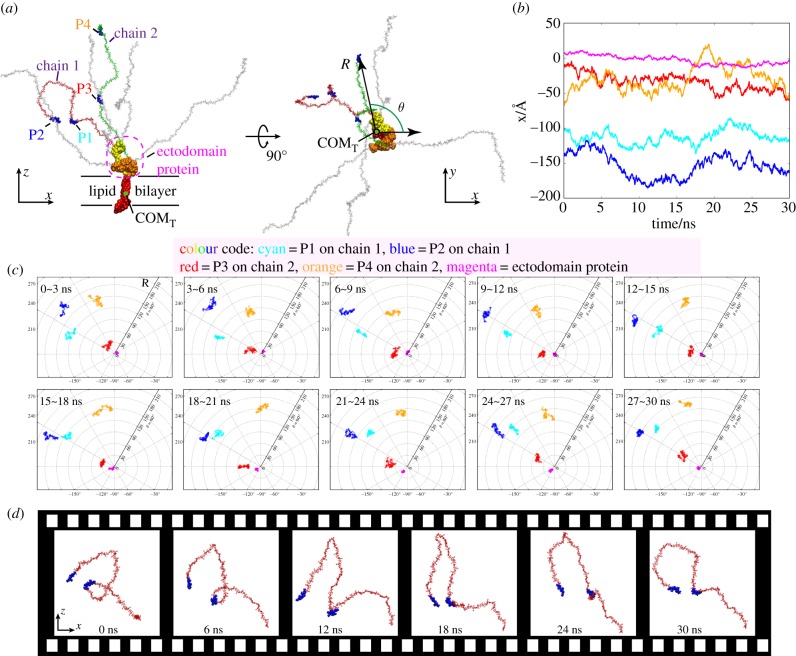
Dynamics of the glycocalyx. (a) Five segments of interest and definition of the polar coordinates. The snapshot is taken at the instant of 30 ns. In the following analyses, the positions of COMT in all the frames in the 30 ns simulations are aligned. (b) The selected five segments swing in the x-direction. (c) Evolutions of the COMs of the five segments of interest in polar coordinates. The colour code is valid for (b) and (c). (d) Successive snapshots of the sugar chain undoing its coil via wavy movement.